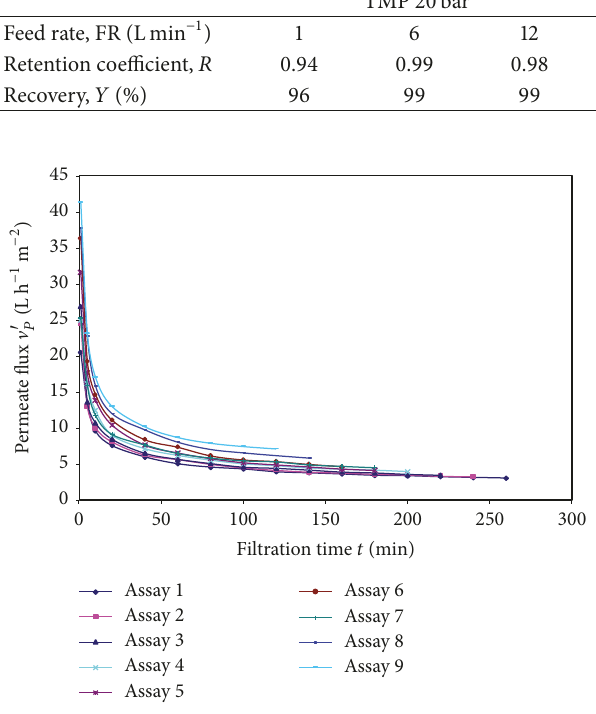
Figure 2: Variation of average permeate flux during nanofiltration